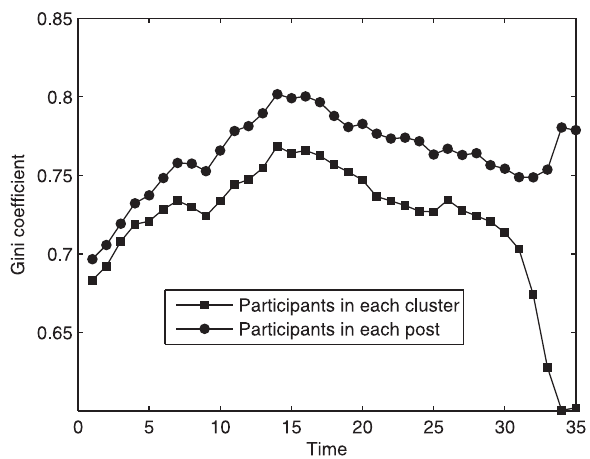
Figure 4. Gini coefficient for the distribution of participants in each topic cluster and in each post as a function of time in Tianya BBS. The two Gini coefficients increase quickly in the early stage. However, the Gini coefficient for posts’ participants eventually tends to become relatively stable, while the Gini coefficient for clusters’ participants may decrease